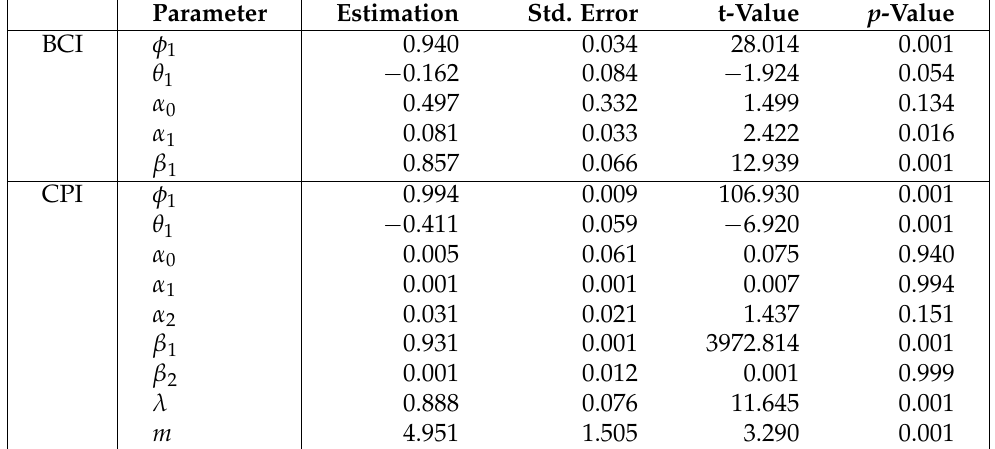
Table 5. Estimated parameters of ARMA ( 1,1 ) -TGARCH ( 1,1 ) and ARMA ( 1,1 ) -TGARCH ( 2,2 ) mod- els for BCI and CPI time series, respectively.